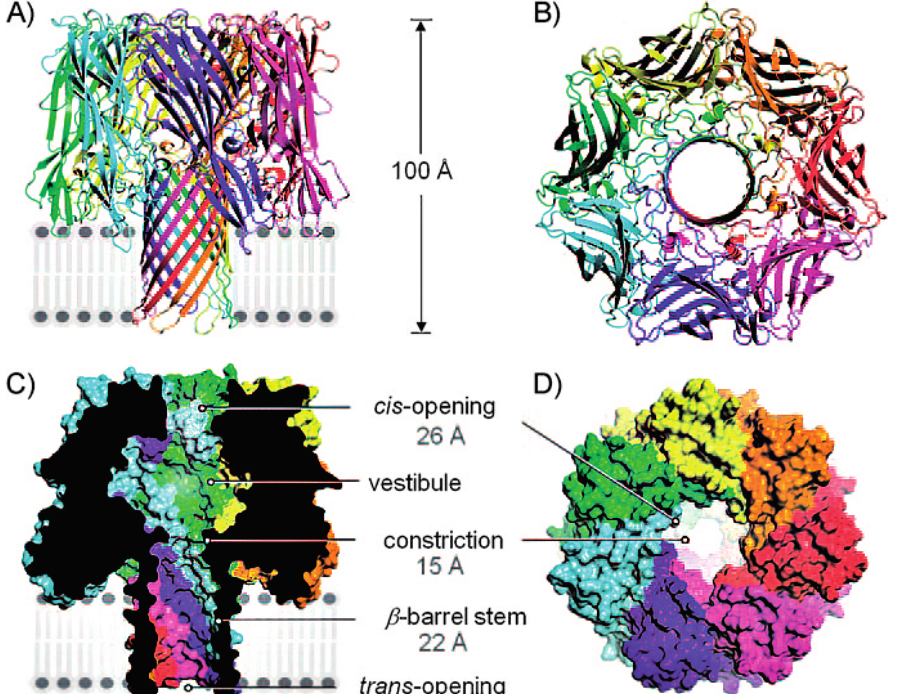
Figure 1. ( A ) Observe the position between the α -HL nanopores with the lipid bilayer; ( B ) View of α -HL from the cis side to the pore; ( C , D ) The cross section and the space filling model show that the hole diameter of α -HL in different locations. Reproduced with permission from